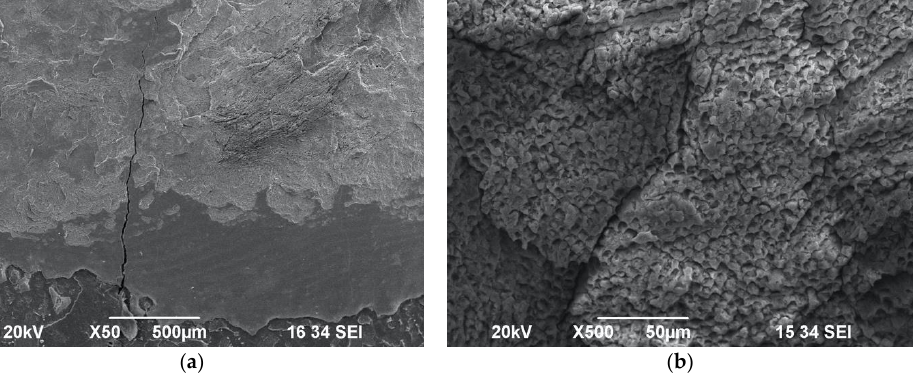
Figure 7. SEM images of enamel surface morphology following irradiation with 1 W/20 Hz/50 mJ/17 J/cm 2 with maximum water spray cooling—Group G—under ×50 magnification ( a ) and ×500 magnification, ( b ) showing scaly surface and impact craters with exposed prisms.